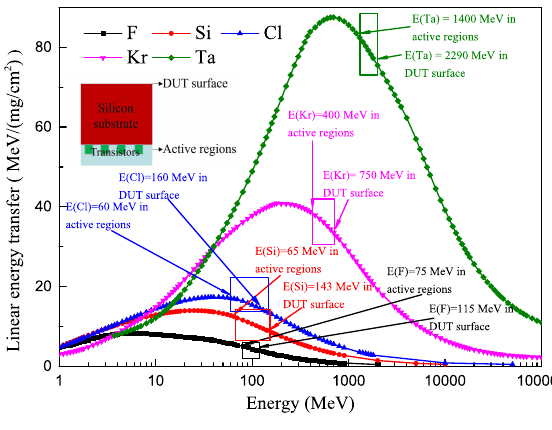
Figure 5. Experimental heavy-ion types and